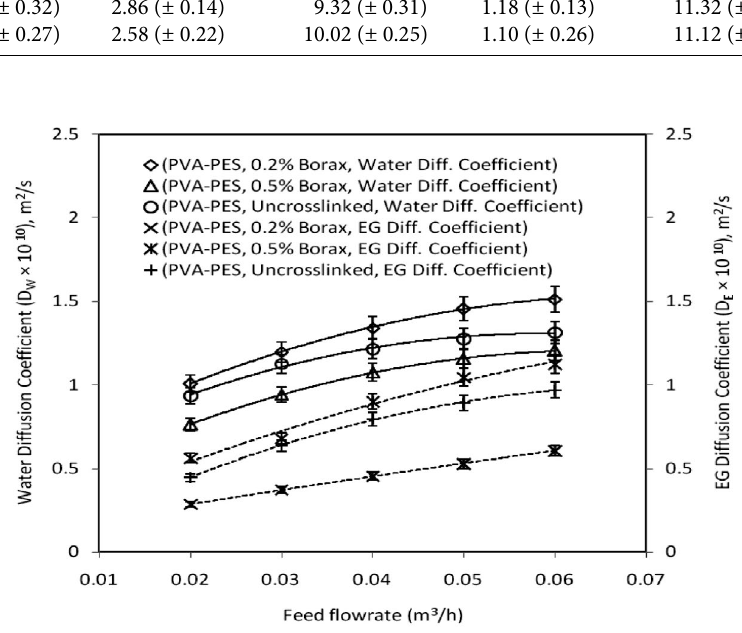
Fig. 10. Water and ethylene glycol diffusion coefficient as a function of feed flow rate in the pervaporation of EG-water mixture (Temperature: 45 o C, Feed concentration: 80% Ethylene glycol by